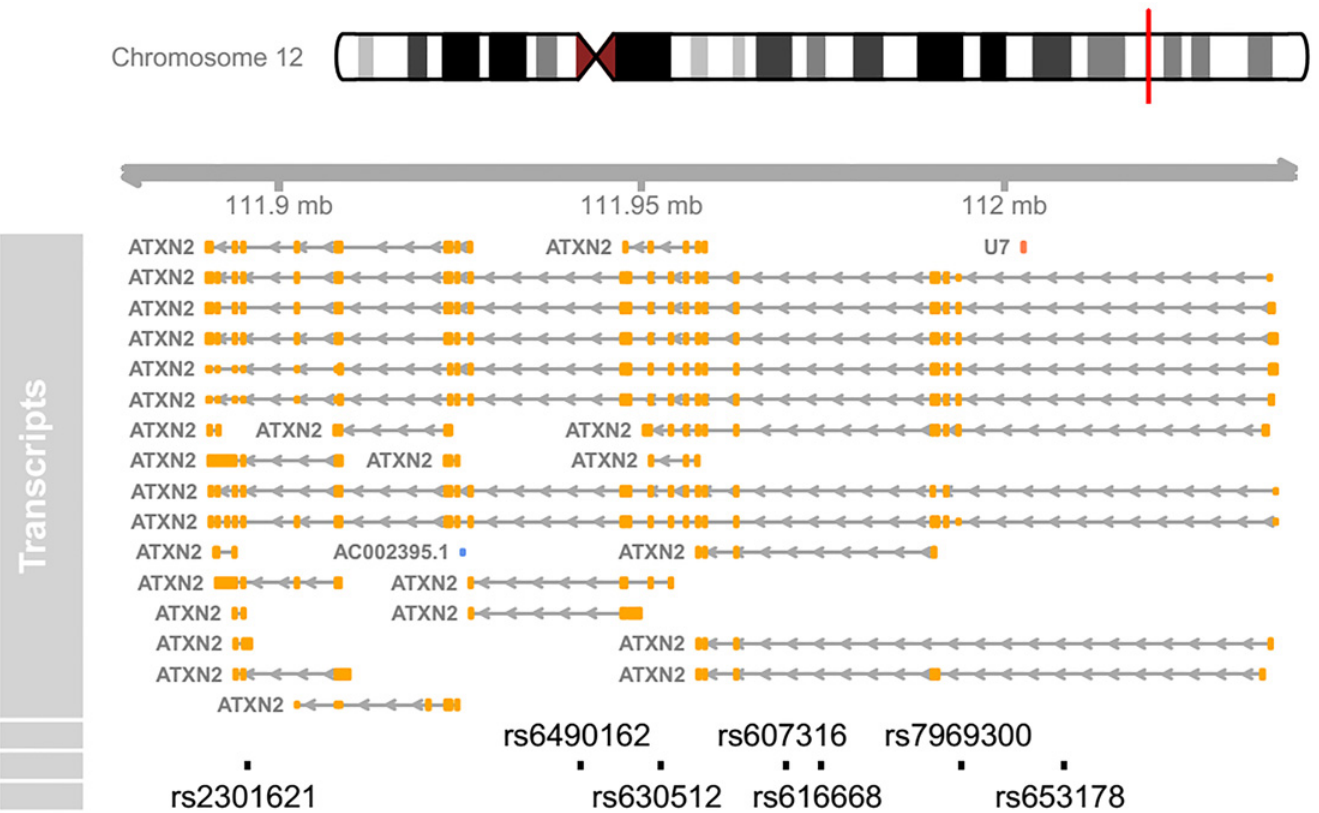
Fig 1. A detailed genomic map for seven SNPs within ATXN2 using Ensembl database. At the top, the relevant chromosome is drawn with the subregion of interest marked in red. The ‘ Transcript ’ track shows all the alternative transcripts within the region, retrieved from Ensembl database, including a non-ATXN2 transcript U7. At the bottom, the SNPs ’ location and ID are plotted along the same genomic coordinate.